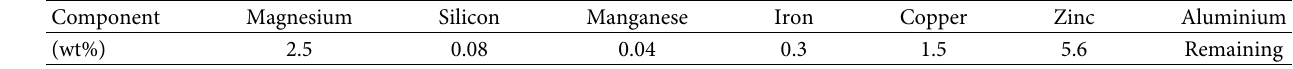
Table 1: Chemical arrangement of